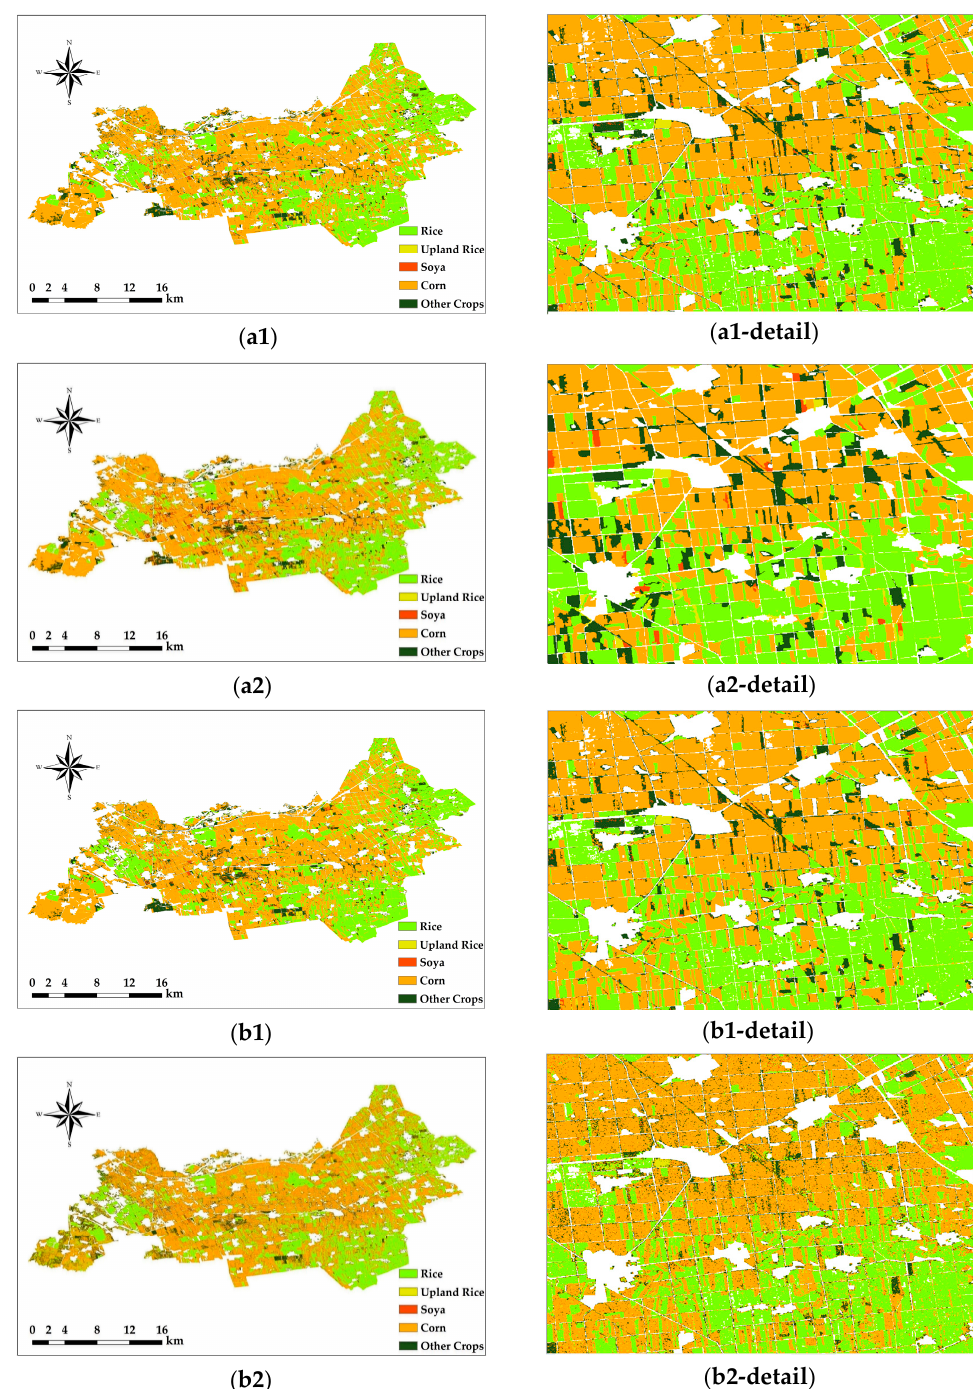
Figure 6. Pixel-based classification results. Only Sentinel-2 images were used in ( a1 , a2 ), Sentinel-1 SAR and Sentinel-2 images were used in ( b1 , b2 ), the RF method was used in ( a1 , b1 ), and the SVM method was used in ( a2 , b2 ). The number of each figure corresponds to that in Table 5.